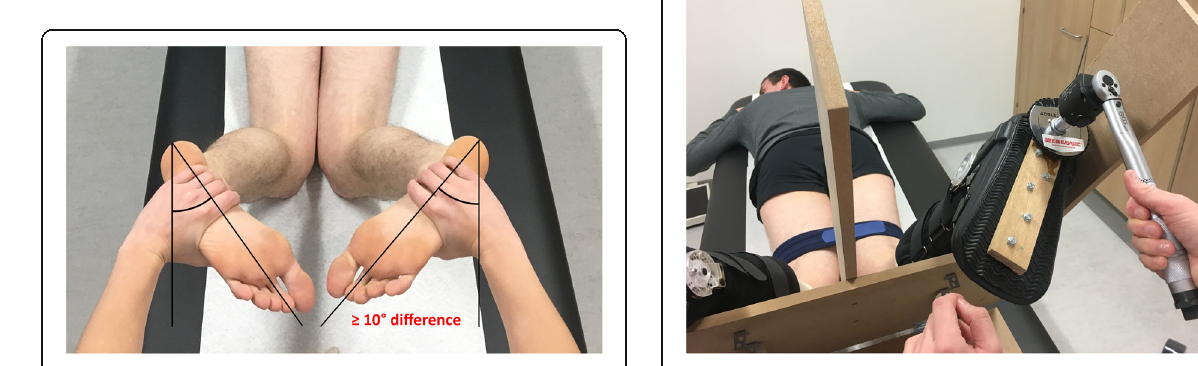
Fig. 2 Positive TIR test of the right knee in 60° of flexion of the knees Fig. 3 Internal rotation with 6 Nm